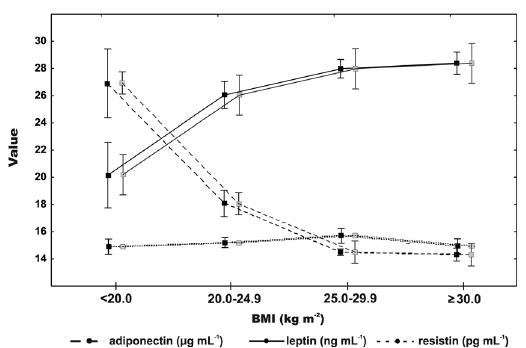
Figure 1. Mean adipokines levels (adiponectin, leptin, resistin) non-adjusted (black small boxes) and adjusted (grey small boxes) for sex and age across four body mass index categories. Boxes represent mean values, “whiskers” represent a 95% confidence interval (CI). The CIs in resistin levels are very narrow, so that are hardly